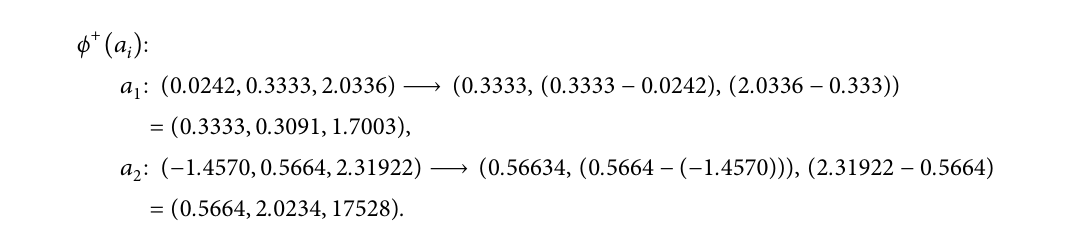
Table 12: Fuzzy preference function, 􏽥 P